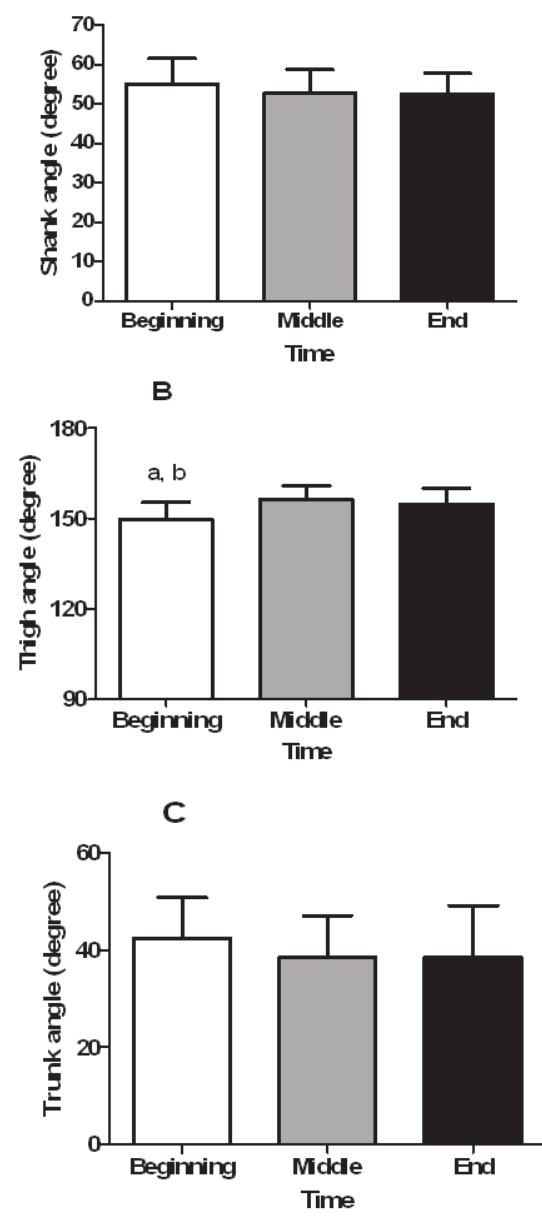
Figure 2. Vertical jump height (A) and duration (B) in different time. A: a different from the end ( p < .001); b different from the middle ( p = .018). B: a different from the end ( p = .04); b different from the middle ( p = .03).